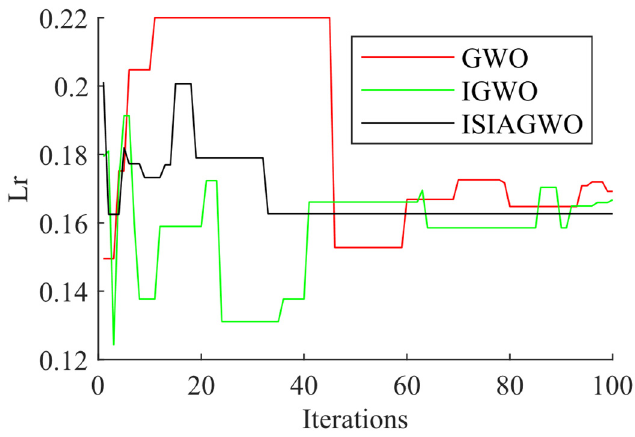
Figure 16. The rotor inductance of DFIG identification convergence curve. The stator ‐ rotor mutual inductance of DFIG identification convergence curve, shown in Figure 17.